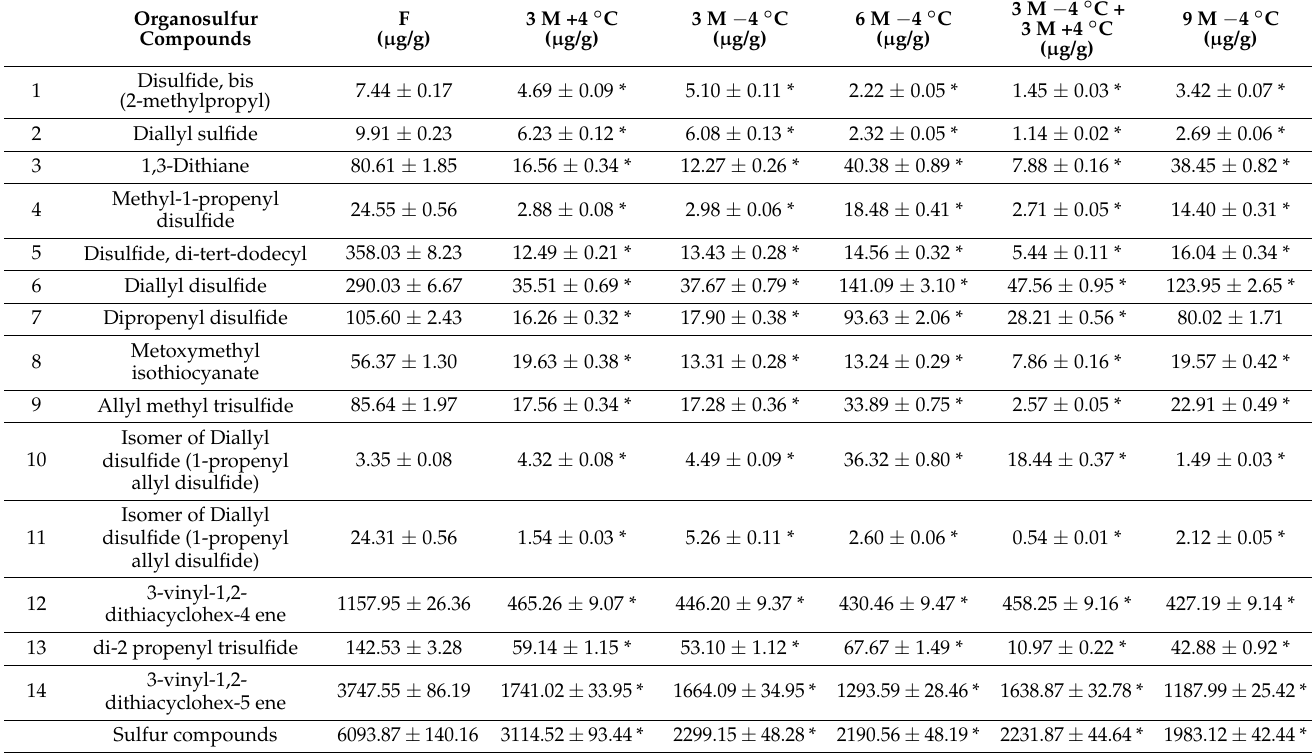
Table 2. Organosulfur compound composition in fresh Voghiera garlic diethyl ether extract (D-VGE) and after different storage periods ( µ g/g of fresh matter, n = 3 ± SD). * p < 0.05 vs. fresh garlic.